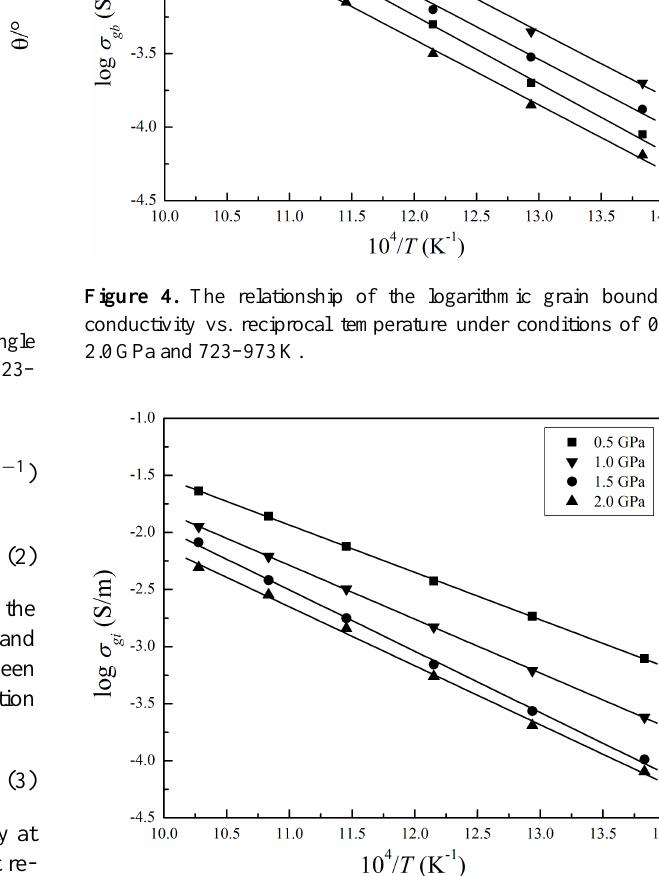
Figure 5. The relationship of the logarithmic grain interior conduc- tivity vs. reciprocal temperature under conditions of 0.5–2.0GPa and